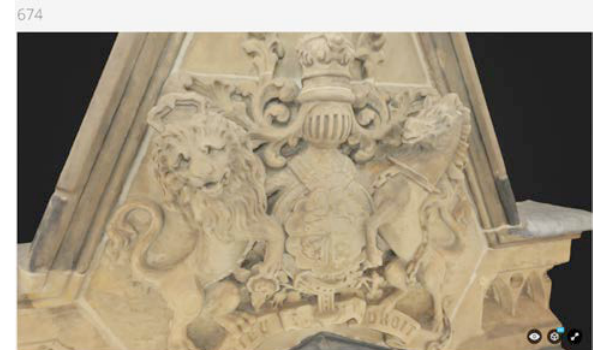
Figure 7. Mesh with texture, opened with HTML database